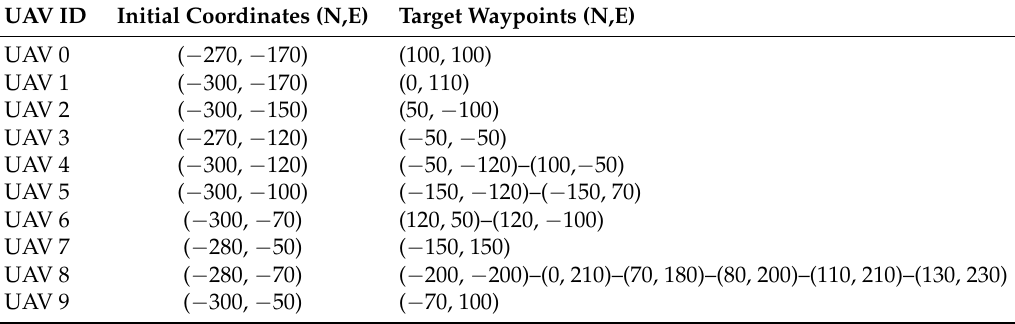
Table 3. Simulation of collision avoidance of MUAVS: Case